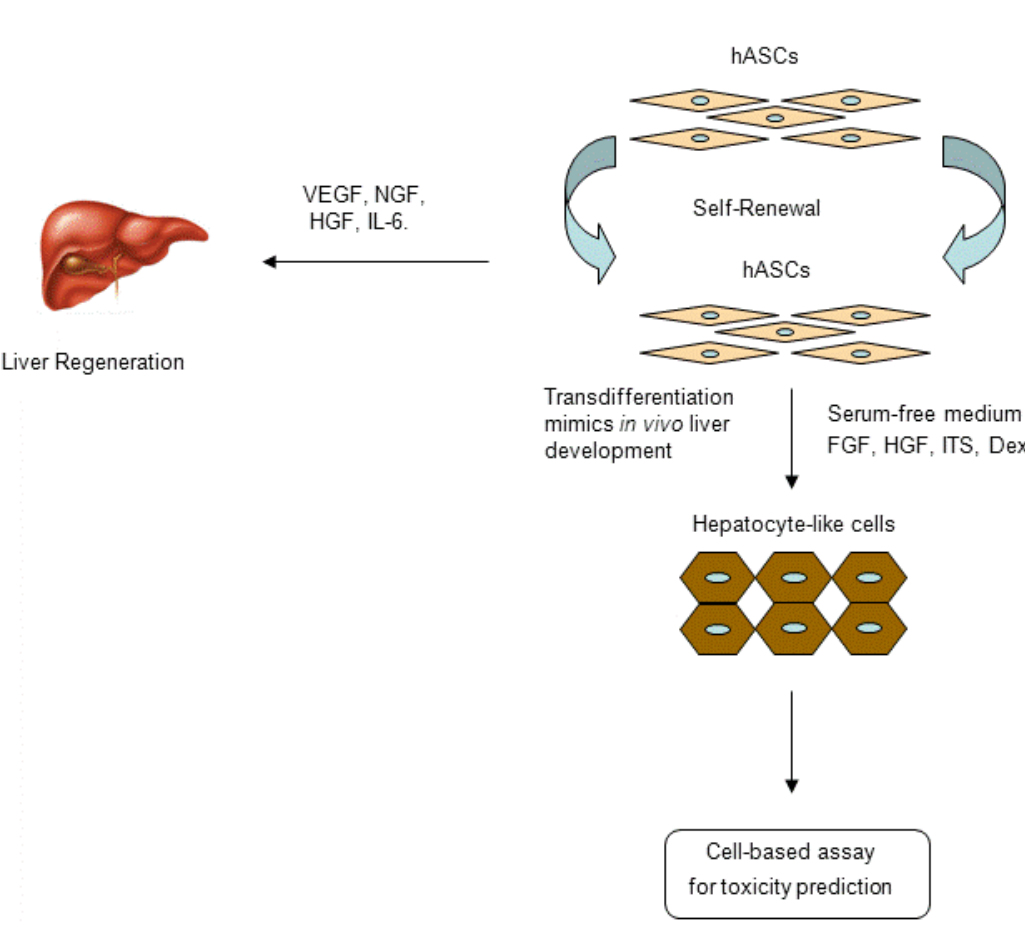
FIGURE 1. ASCs are self-renewing, making them a scale-up cell source. They can also differentiate along the hepatic lineage when cultured in serum-free medium supplemented with hepatic-specific induction factors. ASC-derived hepatocyte-like cells might provide the possibility to be used in toxicity prediction assays. In addition, undifferentiated ASCs secrete growth factors and cytokines that are involved in liver regeneration. Abbreviations: Dex: dexamethasone; FGF: fibroblast growth factor; HGF: hepatocyte growth factor; IL-6: interleukin 6; NGF: neural growth factor; ITS: insulin- transferrin-sodium selenite; VEGF: vascular endothelial growth factor